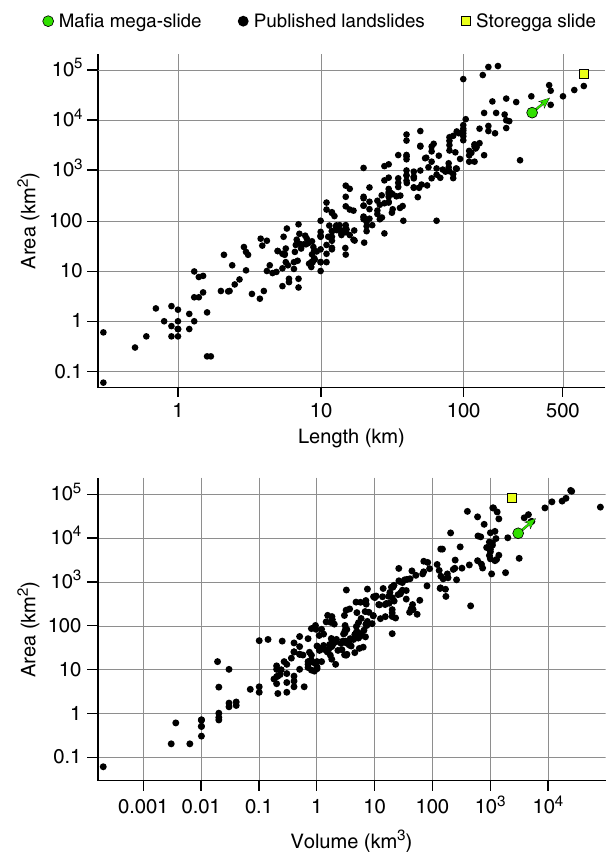
Fig. 7 Morphometry of submarine landslides globally. Landslide area/ length and area/volume ratios for published landslide deposits in comparison with the Ma fi a mega-slide. Data from ref. 60